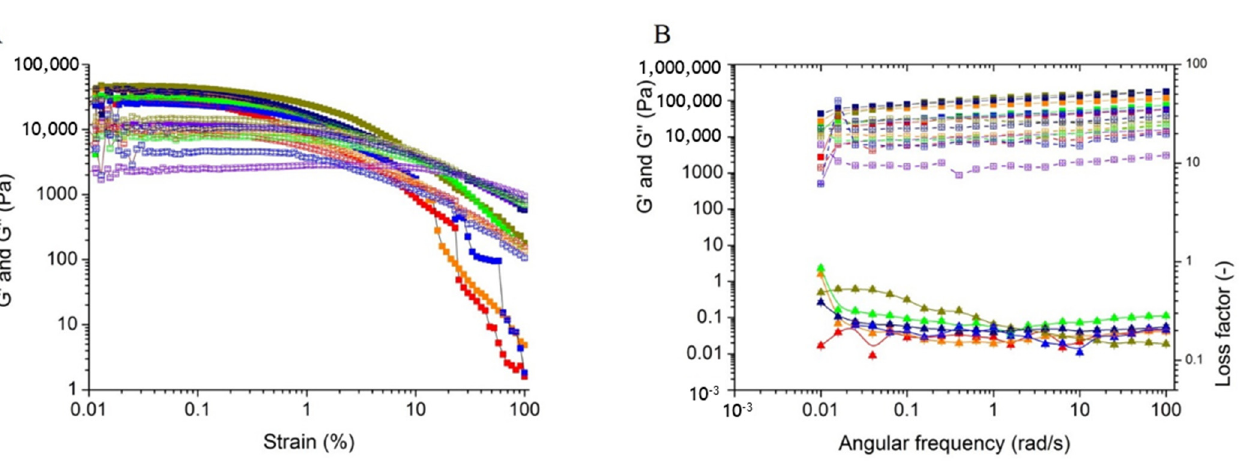
Figure 5. Rheological analysis of the heat pressed films, marked with distinct colors: A (Red), B (Orange), C (Dark Yellow), D (Green), E (Violet), F (Navy), and G (Blue). ( A ) Amplitude sweep with Storage modulus G’ ( ■ ) and Loss modulus ( □ ); ( B ) Frequency sweep with Storage modulus G’ ( ■ ), Loss modulus ( □ ) and Loss factor ( ▲ ) (The reader is requested to refer to the web version for better interpretation). Table 4. Water vapour transmission rate, transparency, water content and thickness of the heat pressed films. Film A Film B Film C WVTR, g/m 2 .d